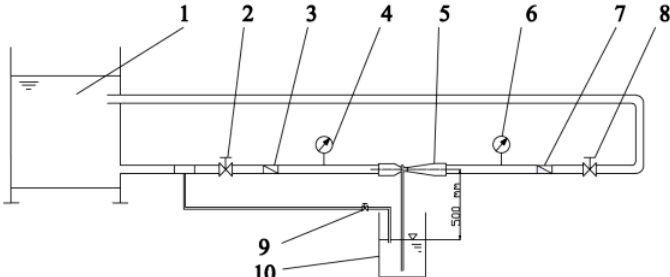
Figure 1. Schematic of the experimental system. 1 . Variable-frequency, constant-pressure water supply device; 2 . Valve 1; 3 . Turbine flowmeter; 4 . Pressure gauge; 5 . Venturi injector; 6 . Pressure gauge; 7 . Turbine flowmeter; 8 . Valve 2; 9 . Valve 3; 10 . Tank.